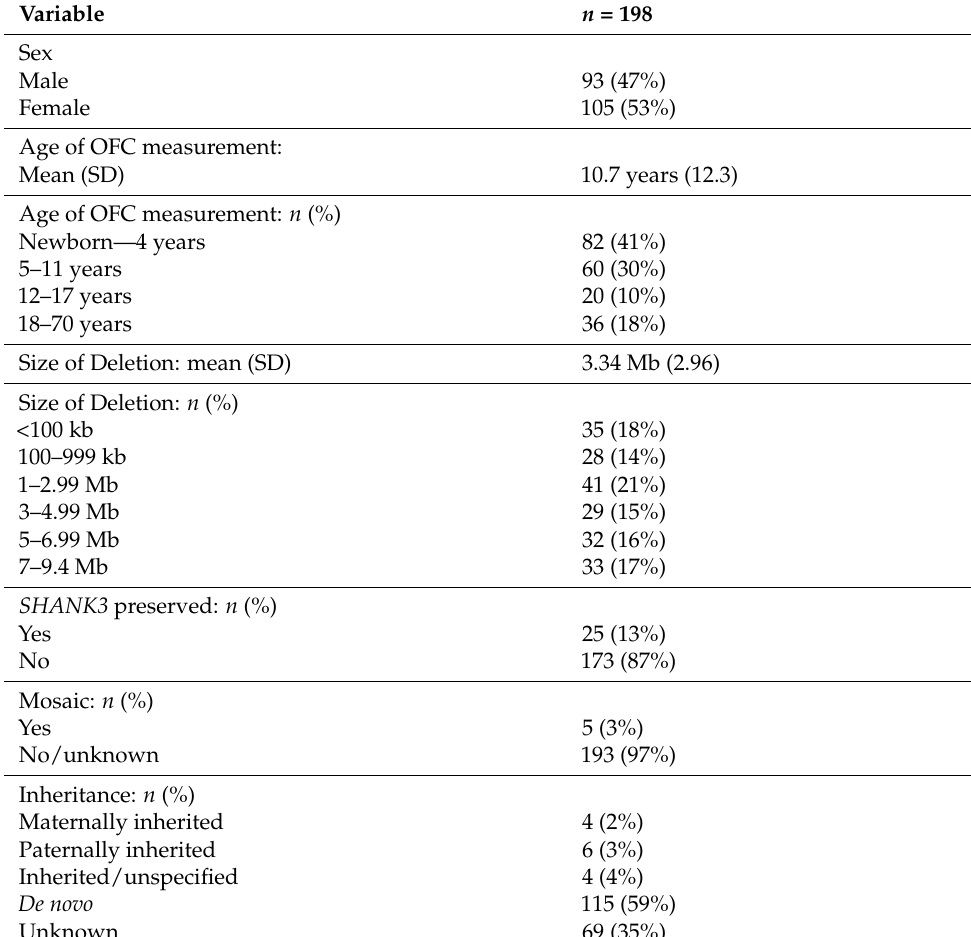
Table 2. Description of 198 cases in the literature with 22q13 deletions with complete data on deletion size and head size.